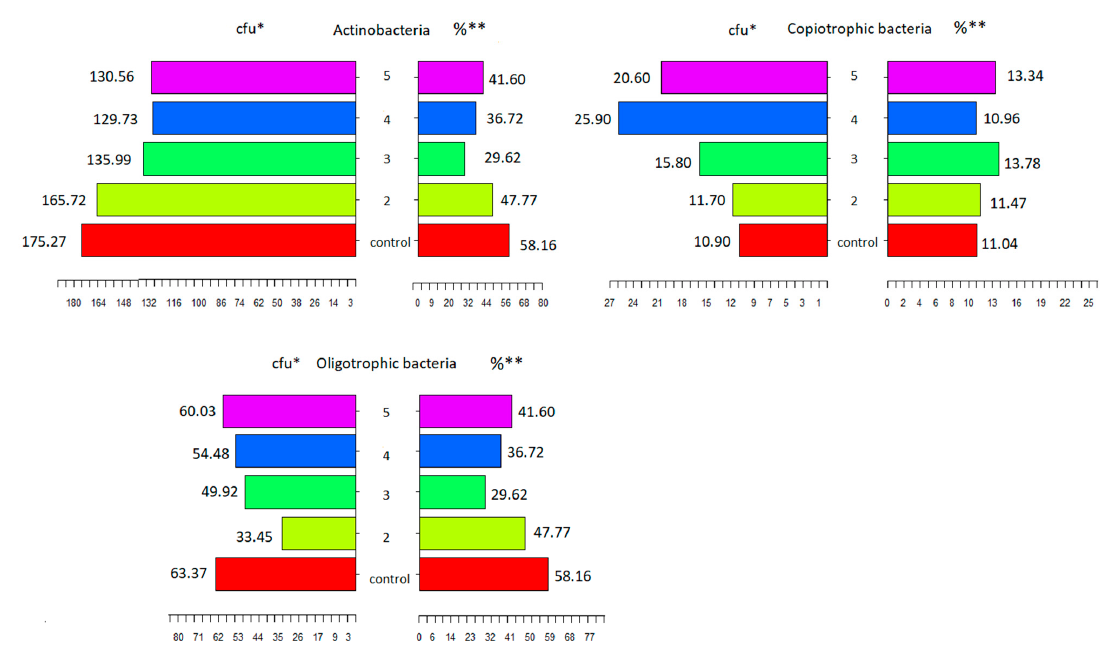
Figure 3. The relation between the count of microorganisms measured with different methods. Abbreviations: cfu *—colony-forming unit, the count of microorganisms measured on selective culture media; % **—the percentage of microorganisms measured by metagenomic analysis; control—conventional tillage (CT) before sowing spring wheat without a cover crop; 2—conventional tillage (CT) skimming before sowing the cover crop and sowing spring wheat after conventional tillage (CT); 3—skimming before sowing the cover crop and sowing spring wheat directly (no-till (NT)) into mulch; 4—sowing the cover crop directly (NT) into the stubble and then sowing spring wheat after conventional tillage (CT) and 5—sowing the cover crop directly (NT) and sowing spring wheat directly into mulch (NT).